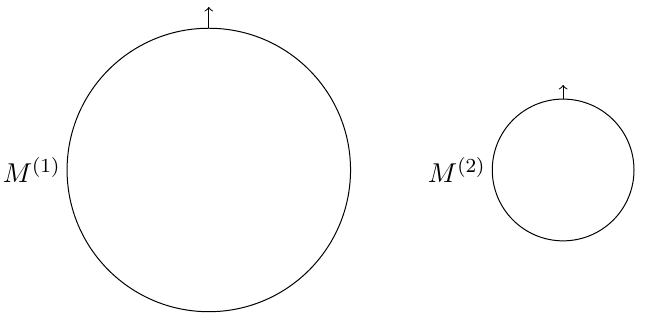
Figure 14 . The con(cid:12)guration of M (1) and M (2) when M (2) is in the exterior of M (1) . The arrows are the ^ n ( i ) which point into the exterior of each surface. The polyhedra which lie directly on the interior of a given M ( i ) are associated with Coxeter group elements of length R , while the polyhedra which lie directly on the exterior of a given M ( i ) are associated with Coxeter group elements of length R + 1. Although we have drawn M (1) and M (2) as circles we are not assuming they are spherical, they could be tori, all we are assuming is that they have a well de(cid:12)ned interior and